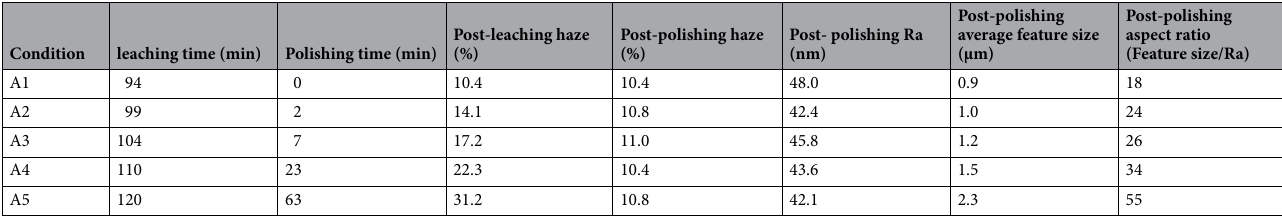
Table 1. Adjust texture feature aspect ratio by leaching and chemically polishing. Leaching is conducted in 20 wt% citric acid and 1 M FeCl 3 at 98.7 °C. Post-leaching chemically polishing is conducted in 10 wt% NaOH at 95